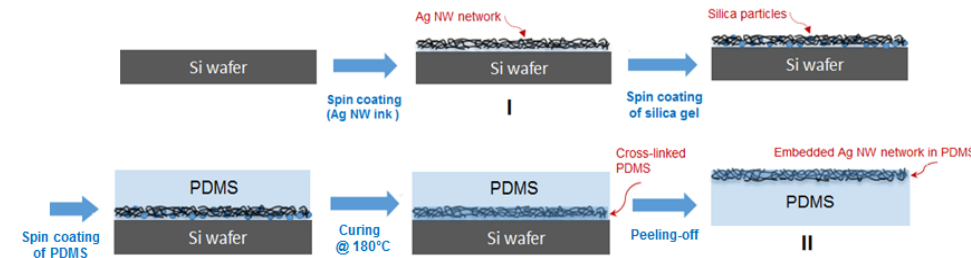
Figure 1. Fabrication of highly strain electrode films based on a Ag NW networks embedded into the cross-linked PDMS